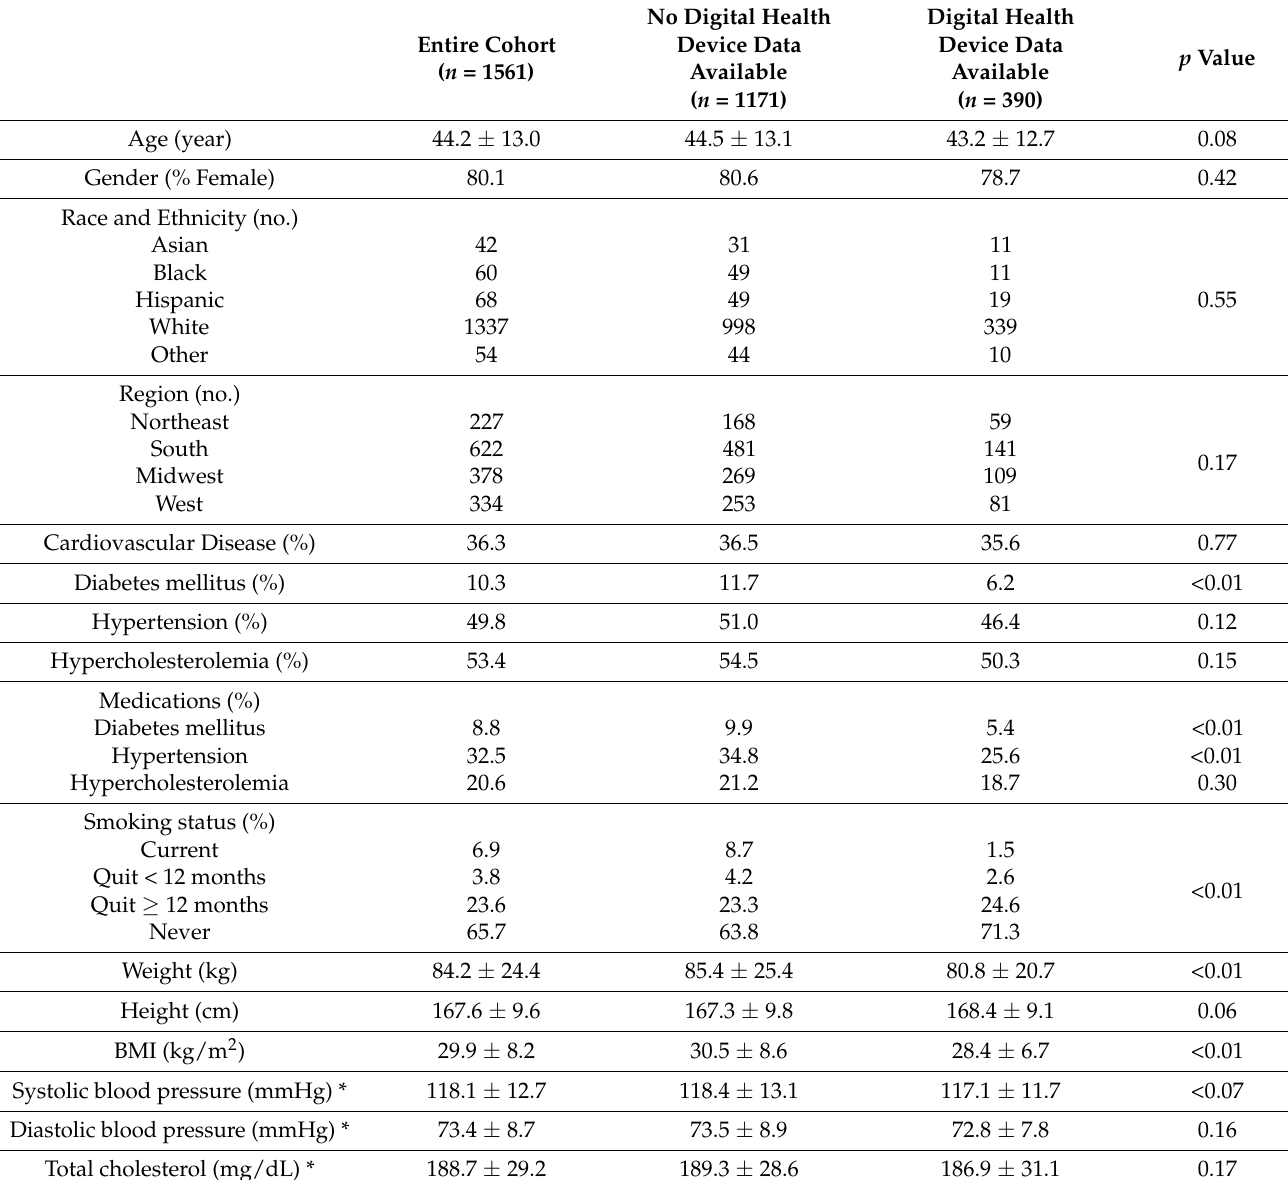
Table 1. Participant self-reported demographics, cardiovascular risk factors, and health